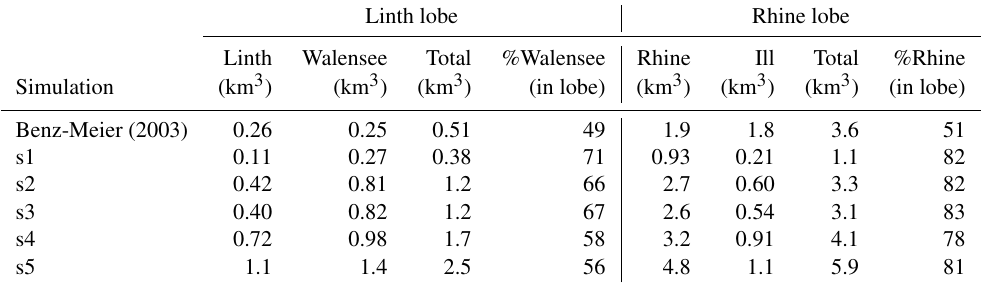
Table 4. Annual ice fluxes for the most important glaciers feeding the Linth and Rhine lobes. Cross sections (gates) at which fluxes are computed are shown in Fig. 13a. For the Benz-Meier (2003) simulation, fluxes are calculated after 50 years of transient simulation with Stokes flow with an evolving ice